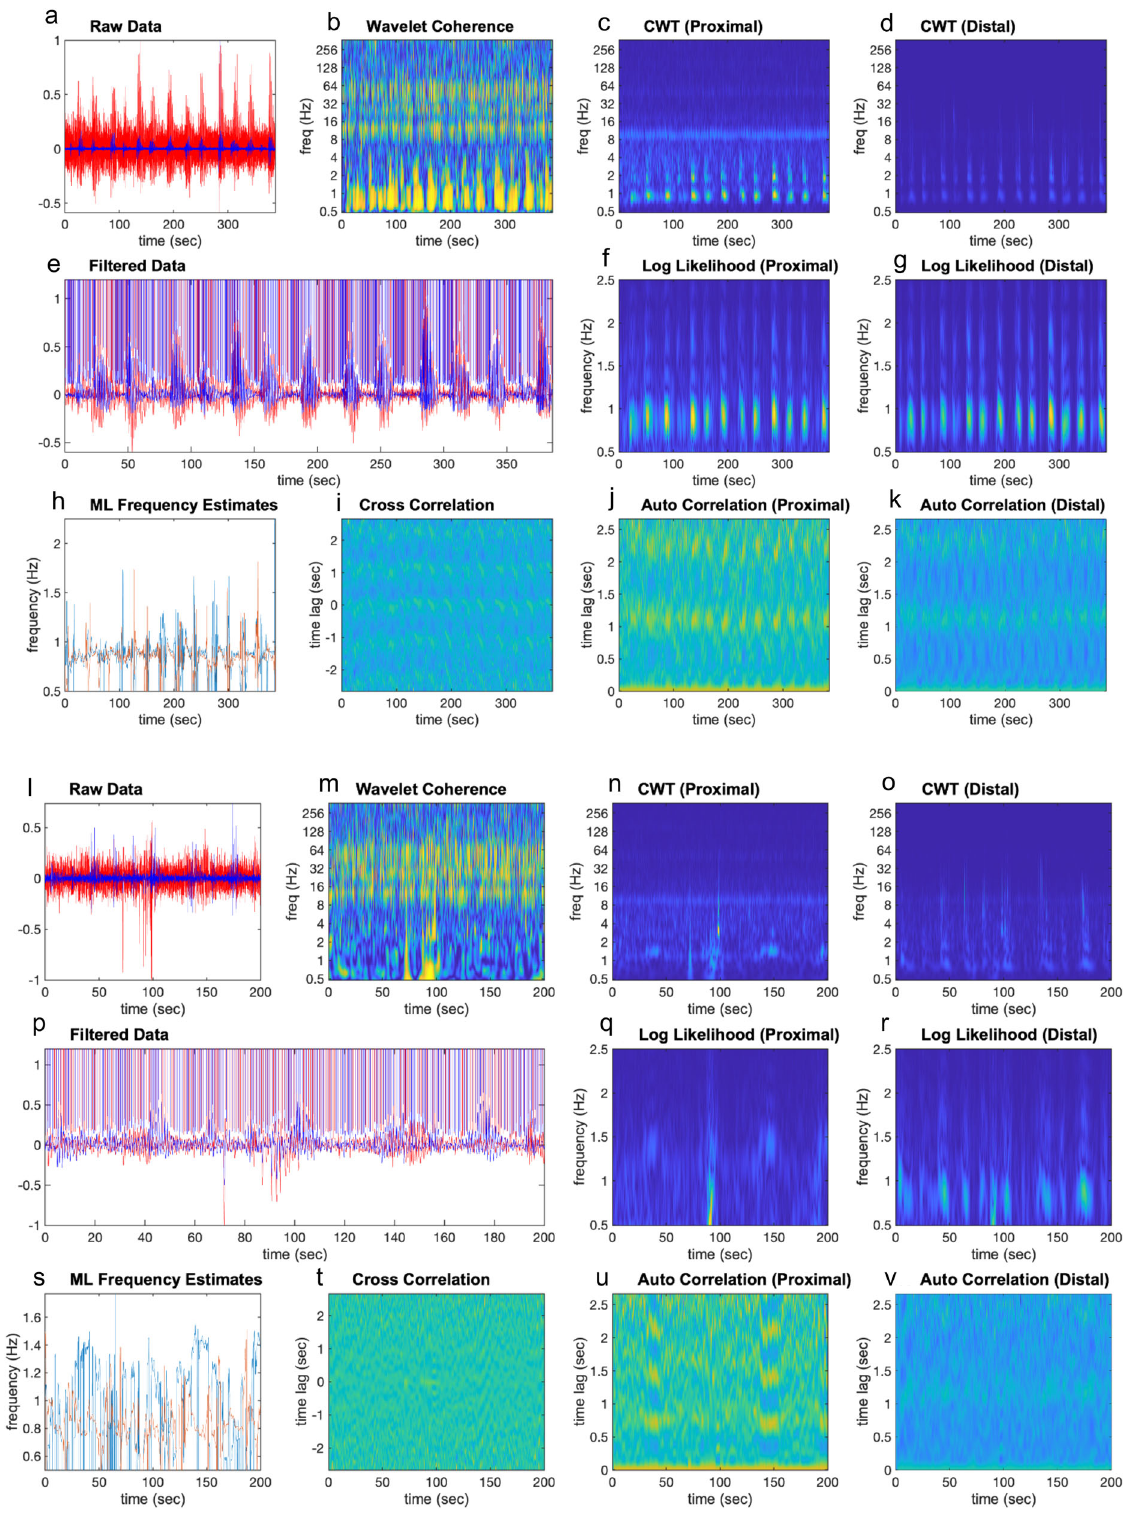
Methods Tissue dissection . C57BL/6 J mice of either sex (1 – 6 months of age) were euthanized using iso fl urane inhalation overdose, followed by cervical dislocation, using a protocol approved by the Animal Welfare Committee of Flinders Uni- versity (ethics approval no.861-13). A midline laparotomy was made and the entire colon, including the caecum and rectum was removed and placed into a Petri dish